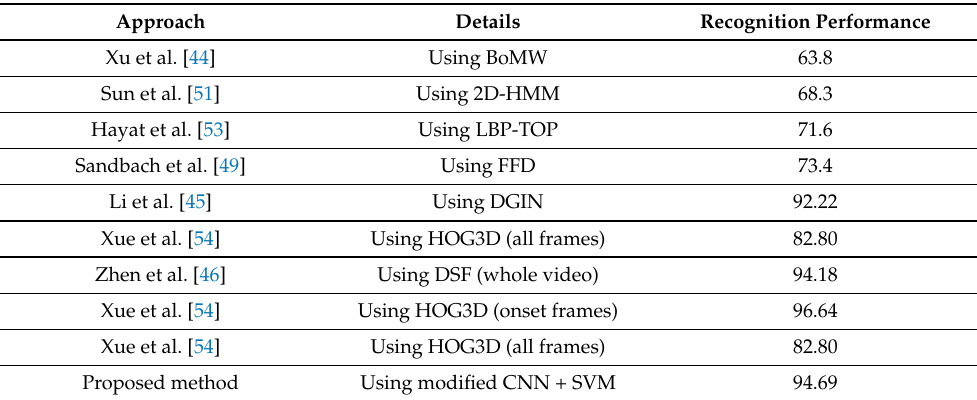
Table 12. Facial expression recognition performance in different approaches for BU4D